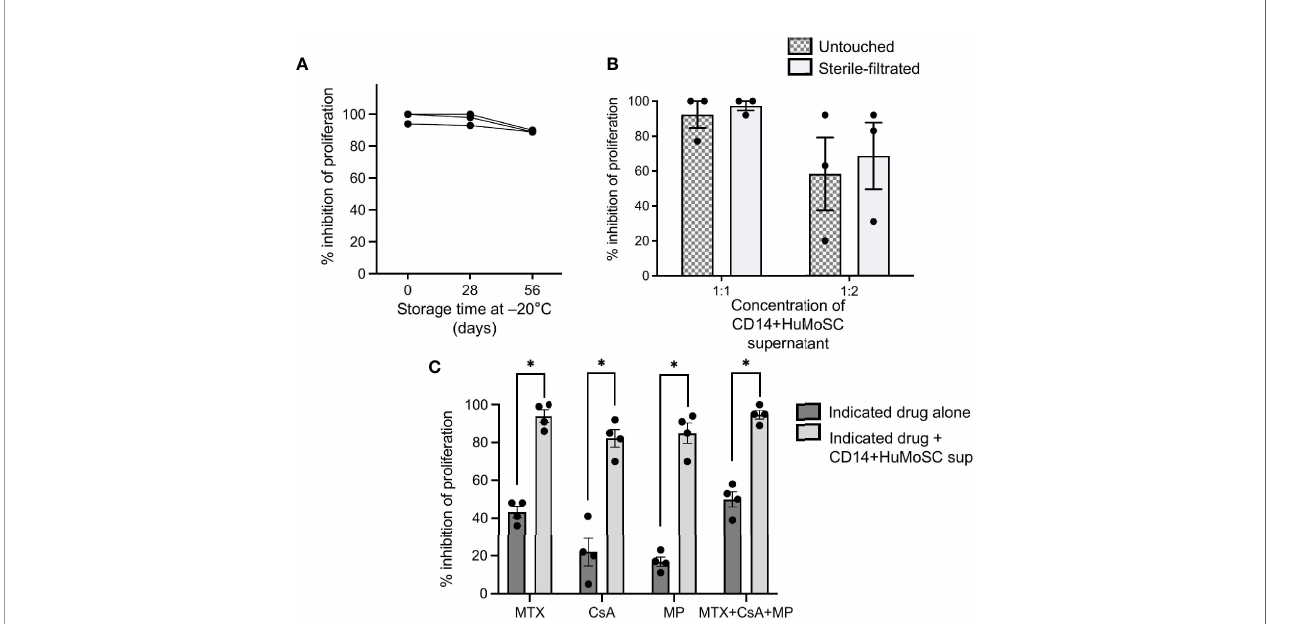
FIGURE 6 | Production of CD14+HuMoSC supernatant for clinical use. (A) PBMC stimulated by anti-CD3/CD28 microbeads were co-cultured for 4 days with fresh or thawed CD14+HuMoSC supernatant after a storage at -20°C for 26 or 56 days, and their proliferation was analyzed by fl ow cytometry with BD LSR II and FlowJo software. (B) PBMC stimulated by anti-CD3/CD28 microbeads were co-cultured for 4 days with CD14+HuMoSC supernatant (volume sup/medium =1:1 or 1:2) recovered before and after fi ltration and their proliferation was analyzed by fl ow cytometry with BD LSR II and FlowJo software. Data for 3 independent experiments are shown. Data are shown as mean ± SEM of representative experiments. (C) 500 000 Cell-Trace Violet labeled PBMC stimulated with anti-CD3/CD28 microbeads were co-cultured in the presence of methotrexate (MTX, 2.5ng/mL), ciclosporin A (CsA, 5ng/mL), methylprednisolone (MP, 25ng/mL) or a combination of them with or without CD14+HuMoSC supernatant. Results for the inhibition of PBMC proliferation are shown for 3 independent experiments. Data are shown as mean ± SEM of representative experiments. Two-tailed Mann Whitney test *p ≤